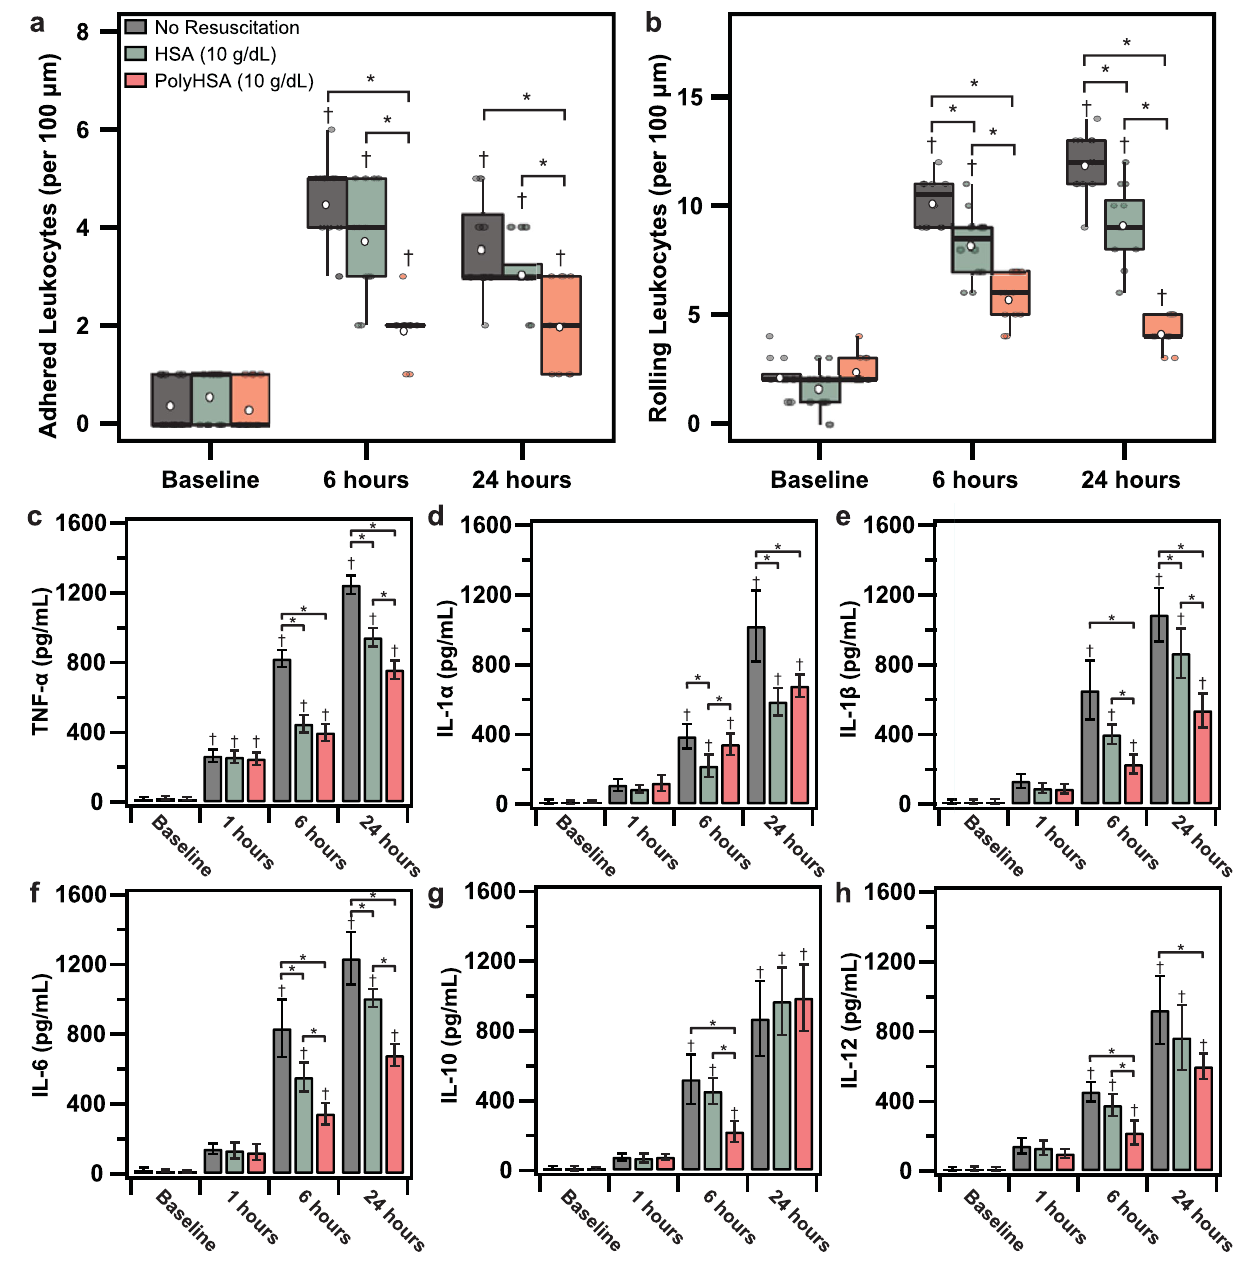
Figure 5. Changes in immune response following LPS induced endotoxemia. Number of ( a ) adhered and ( b ) rolling leukocytes per 100 μm. Increases in serum ( c ) tumor necrosis factor-alpha (TNF-α), ( d ) interleukin 1 alpha (IL-1α), ( e ) interleukin 1 beta (IL-1β), ( f ) interleukin 6 (IL-6), ( g ) interleukin 10 (IL-10), and ( h ) interleukin 12 (IL-12) as measured with ELISA with no resuscitation, infusion of HSA, or infusion of PolyHSA. Data are presented as mean and SD or as boxplots where whiskers indicate 95% CI and boxes indicate data quartiles. *P < 0.05 between groups, † P < 0.05 compared to baseline conditions (n = 6 with PolyHSA compared to untreated animals and animals resuscitated with HSA at 6 and 12 h after LPS admin- istration. The FCD significantly (P < 0.05) decreased in the PolyHSA group compared to baseline, and by 24 h the FCD in animals treated with PolyHSA was significantly (P < 0.05) greater than animals in the HSA and no resuscitation treatment groups. Endotoxemia leukocyte endothelial interaction. Changes in the number of leukocytes rolling and adhered to the endothelium is depicted in Fig. 5a,b. At baseline conditions, there were no significant differences in the number of adhered and rolling leukocytes between each treatment group. For all treatment groups, there was a significant (P < 0.05) increase in both adhered and rolling leukocytes after LPS administration. 24 h after resuscitation with HSA, there were significantly fewer adhered and rolling leukocytes compared to animals that